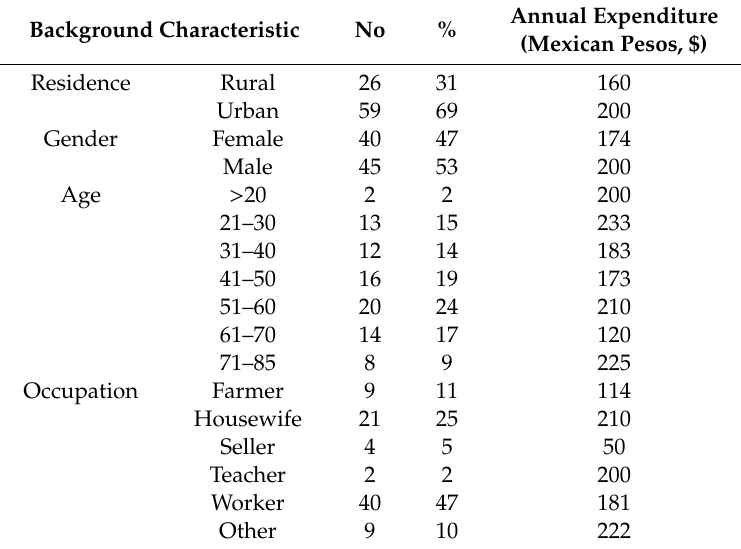
Table 1. Socio-demographic characteristics of the 85